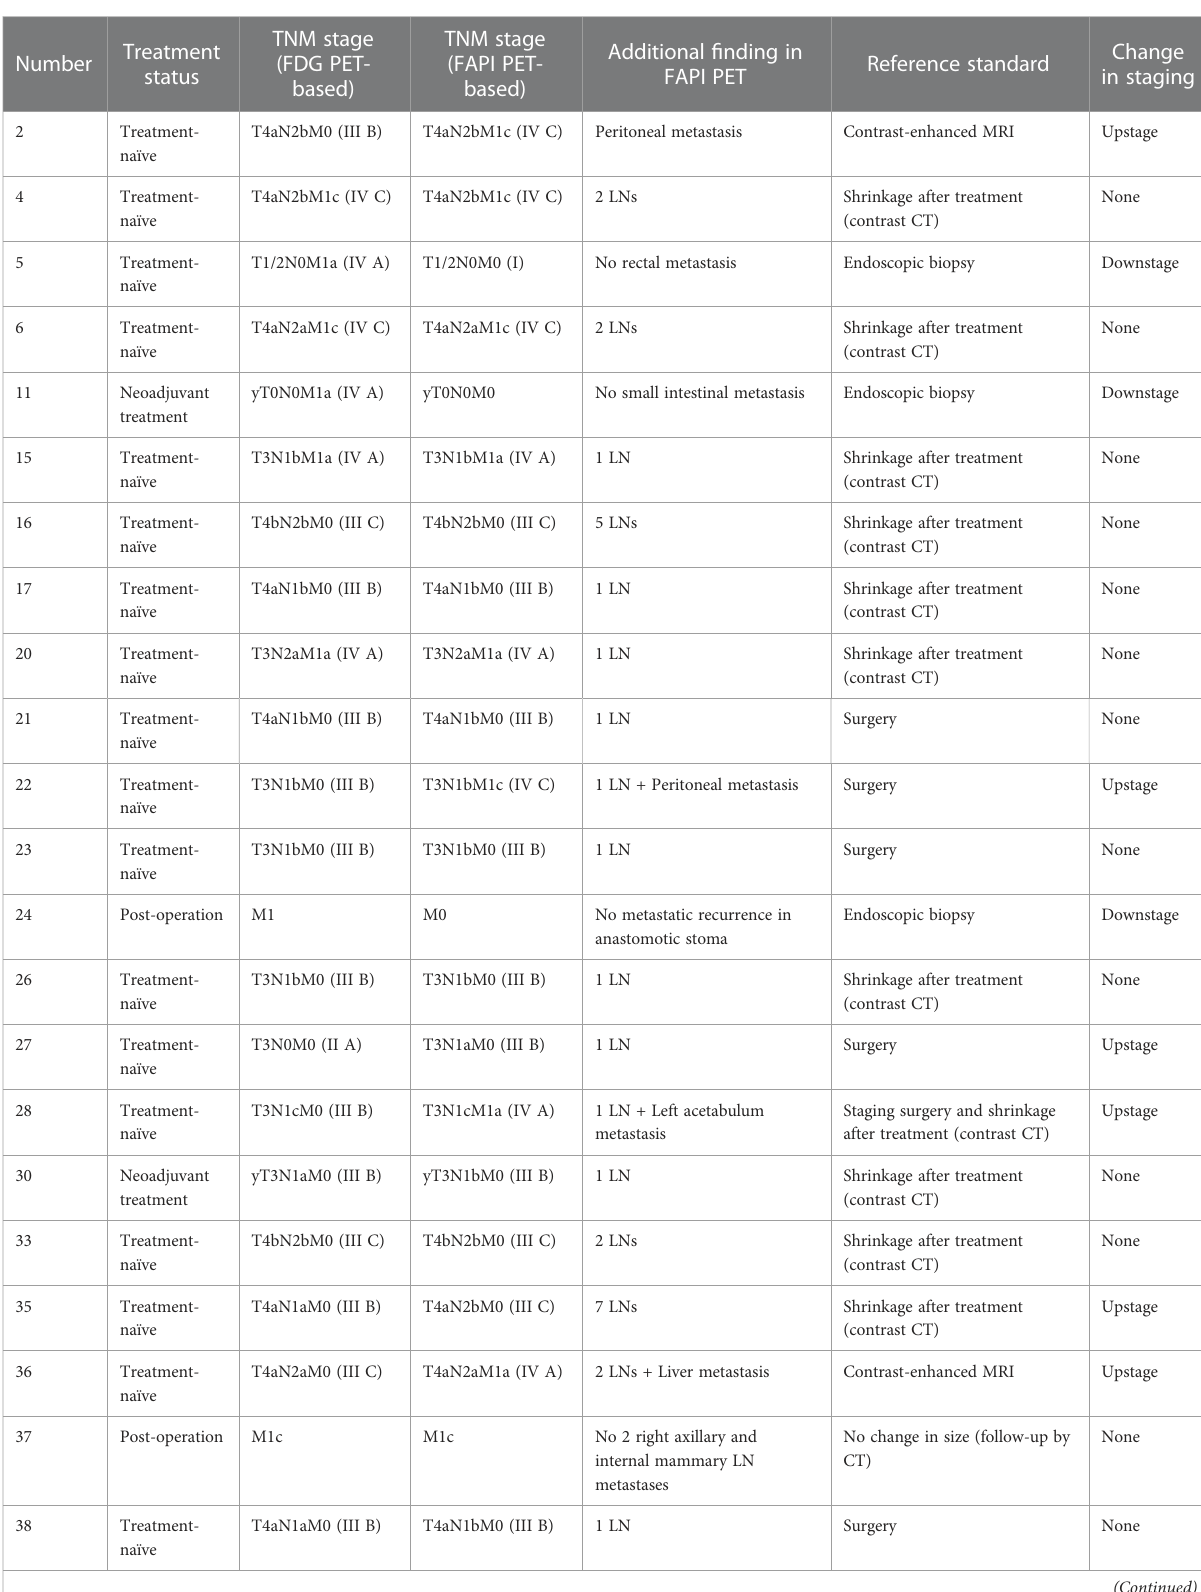
TABLE 2 Comparison of FDG PET-based and FAPI PET-based TNM staging of 34 CRC participants with additional fi